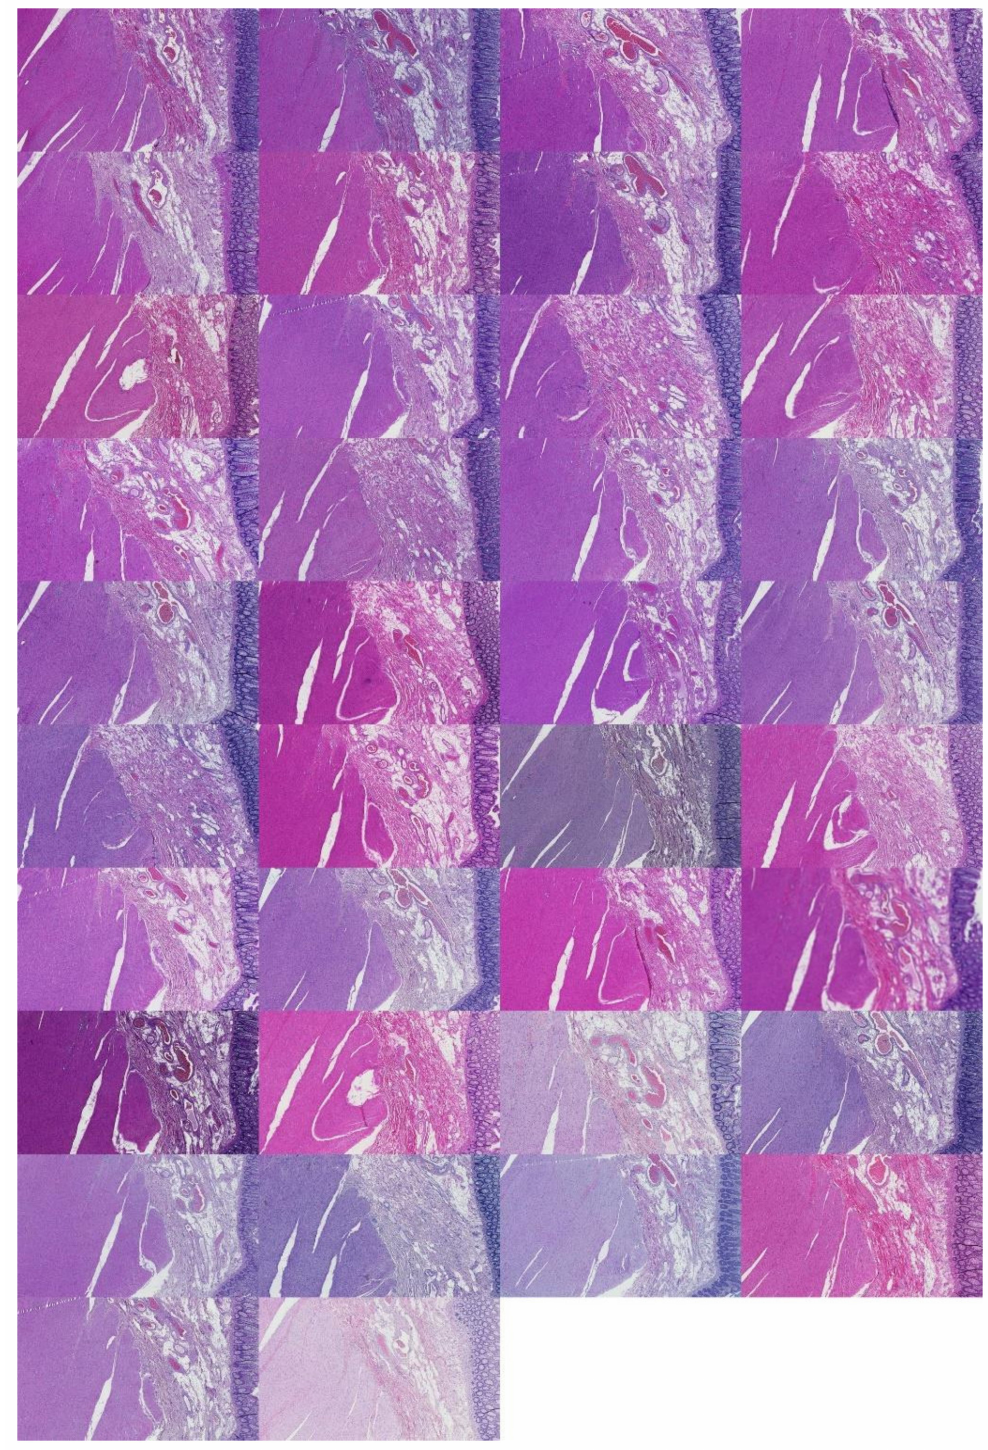
Figure A9. Colon examples visualized by descending silhouette score within the first cluster found (C1). Silhouette values descend in the left direction from the left-most example in the first